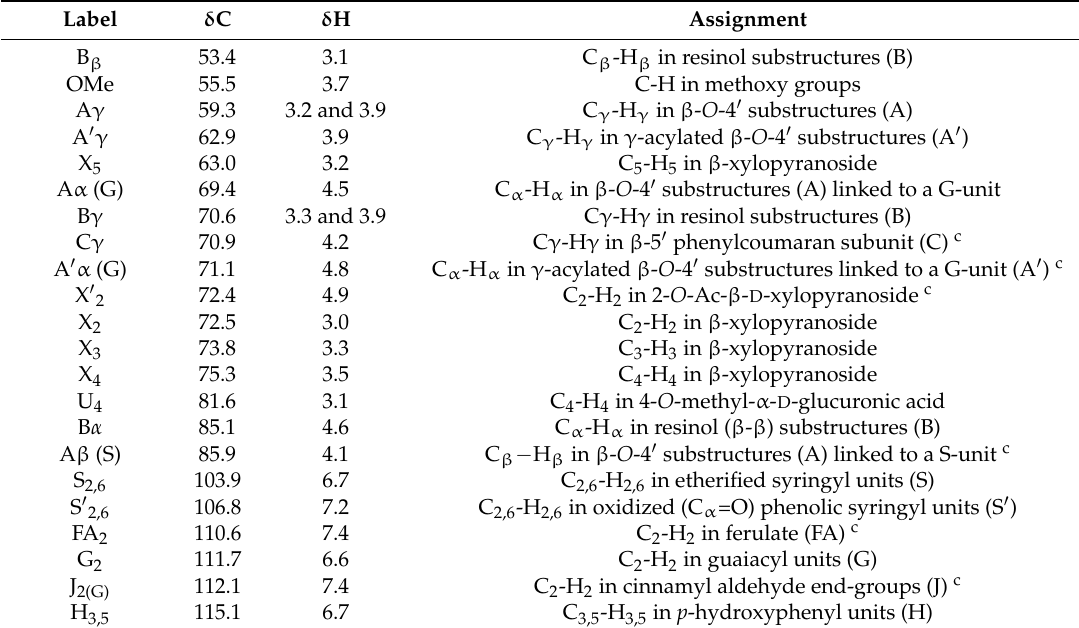
Figure 7. Main molecular structures identified in wheat and Chamaecytisus proliferus lignin extracts by 13 C- 1 H 2D-HSQC NMR spectroscopy. ( A ) β - O -4 ′ linkages; ( A ′ ) β - O -4 ′ linkages with acetylated γ -carbon; ( B ) resinol β - β′ structure; ( C ) phenylcoumaran β -5 ′ subunit; ( H ) p -hydroxyphenyl unit; ( G ) guaiacyl unit; ( S ) syringyl unit; ( S ′ ) oxidized syringyl units with a C α ketone; ( FA ) ferulate; ( PCA ) p -coumarate and ( J ) cinnamyl aldehyde end-groups. Table 5. Assignment of main 13 C- 1 H correlation signals in HSQC spectra of lignin from wheat and Chamaecytisus a shown in Figure 6.